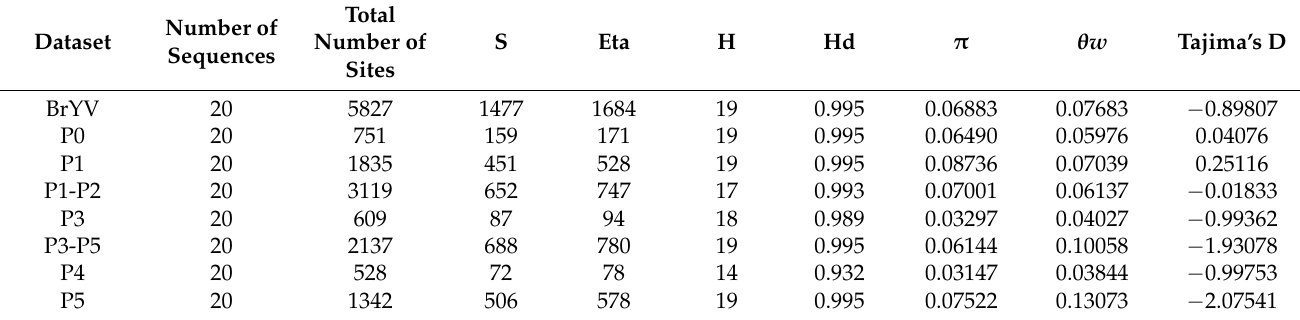
Table 3. Molecular diversity among BrYV populations and individual